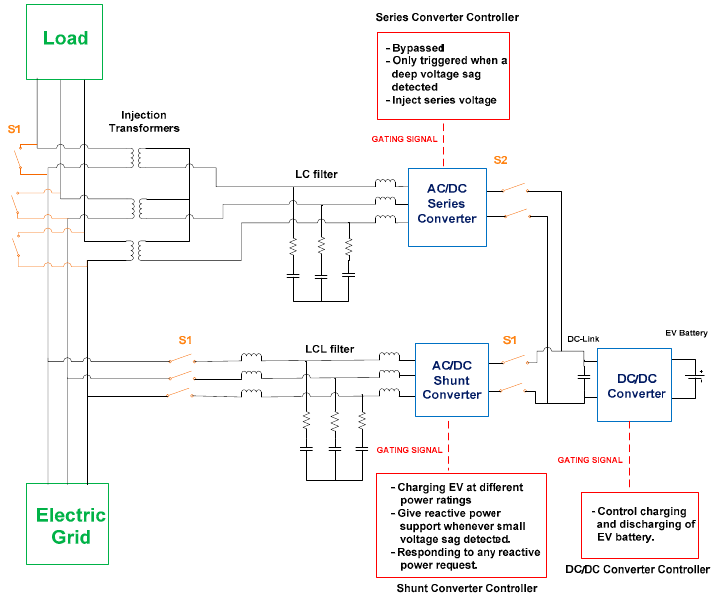
Figure 1. Proposed system topology.